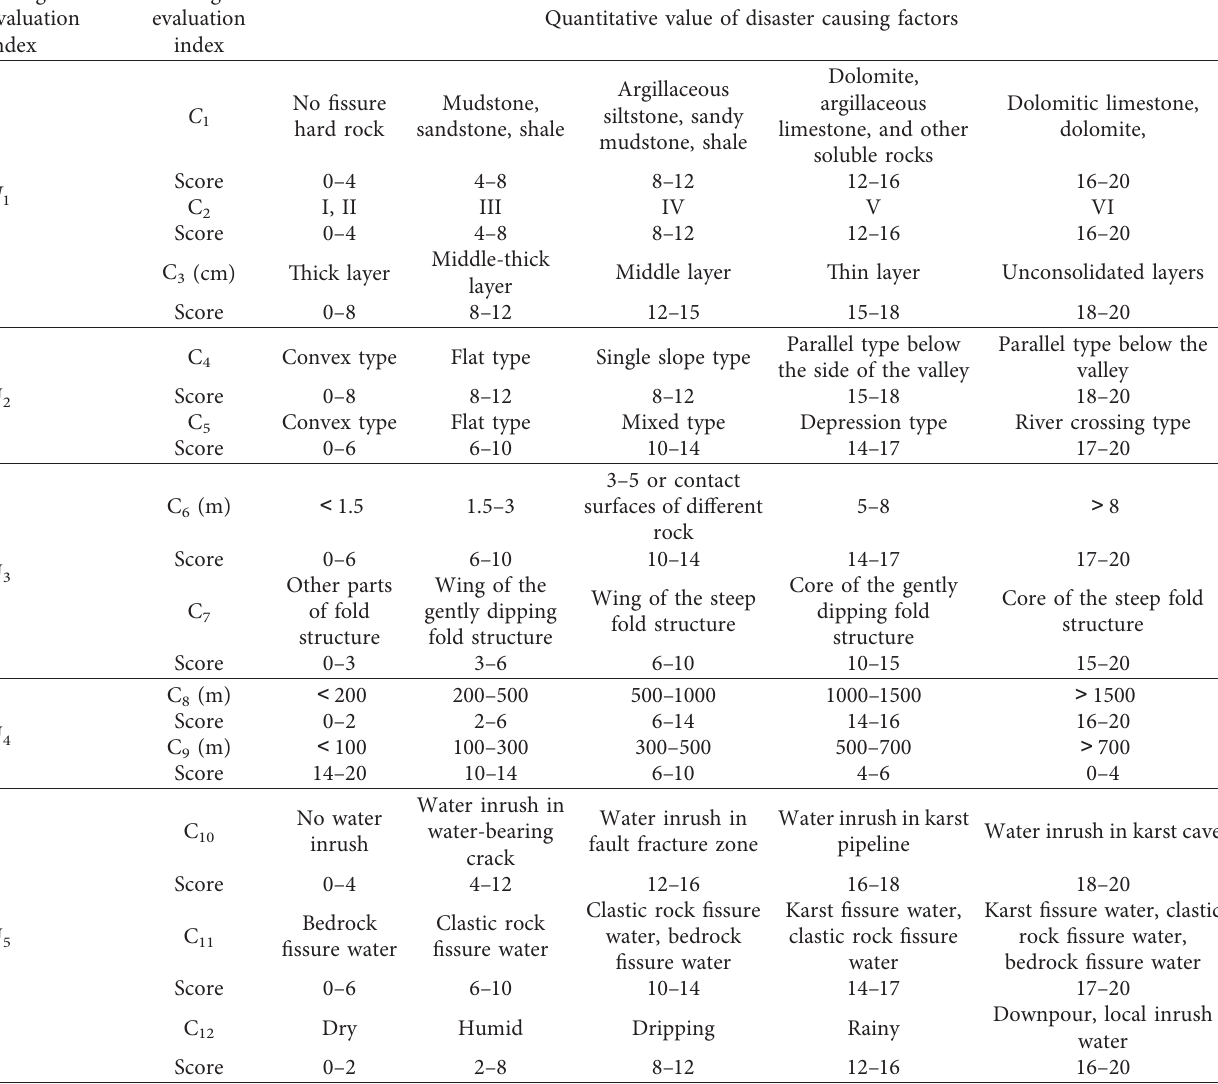
Table 11: Risk grade system evaluation of the water inrush disaster index.